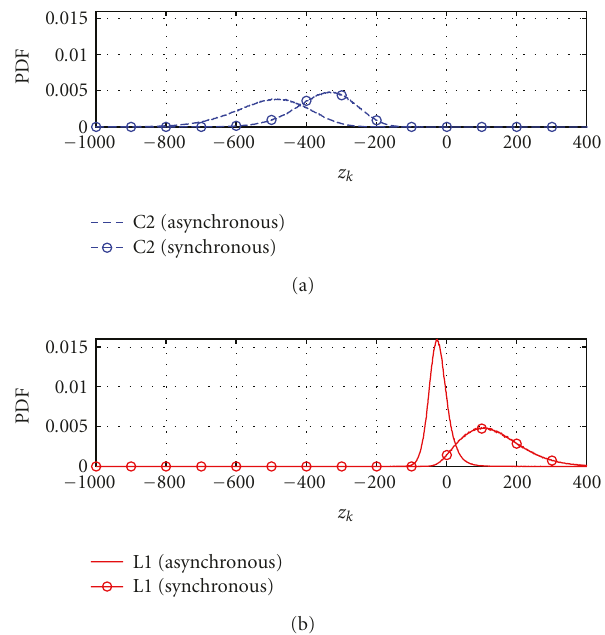
Figure 2: Probability density functions of the decision variables for (a) C2 detector and (b) L1 detector at − 2 . 35 dB SNR ( f m T s = 0 . 2).